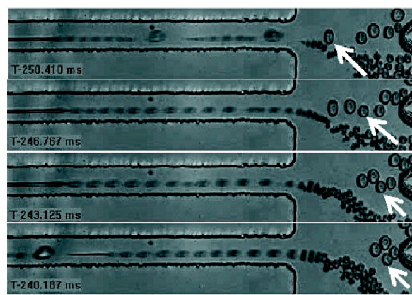
Figure 2. Size-based droplet sorting after cellular encapsulation. A purely hydrodynamic approach for single-cell encapsulation, followed by spontaneous self-sorting of these droplets based on lateral drift of deformable objects in a shear flow, and sterically-driven dispersion in a compressional flow. Reproduction with permission from [37].